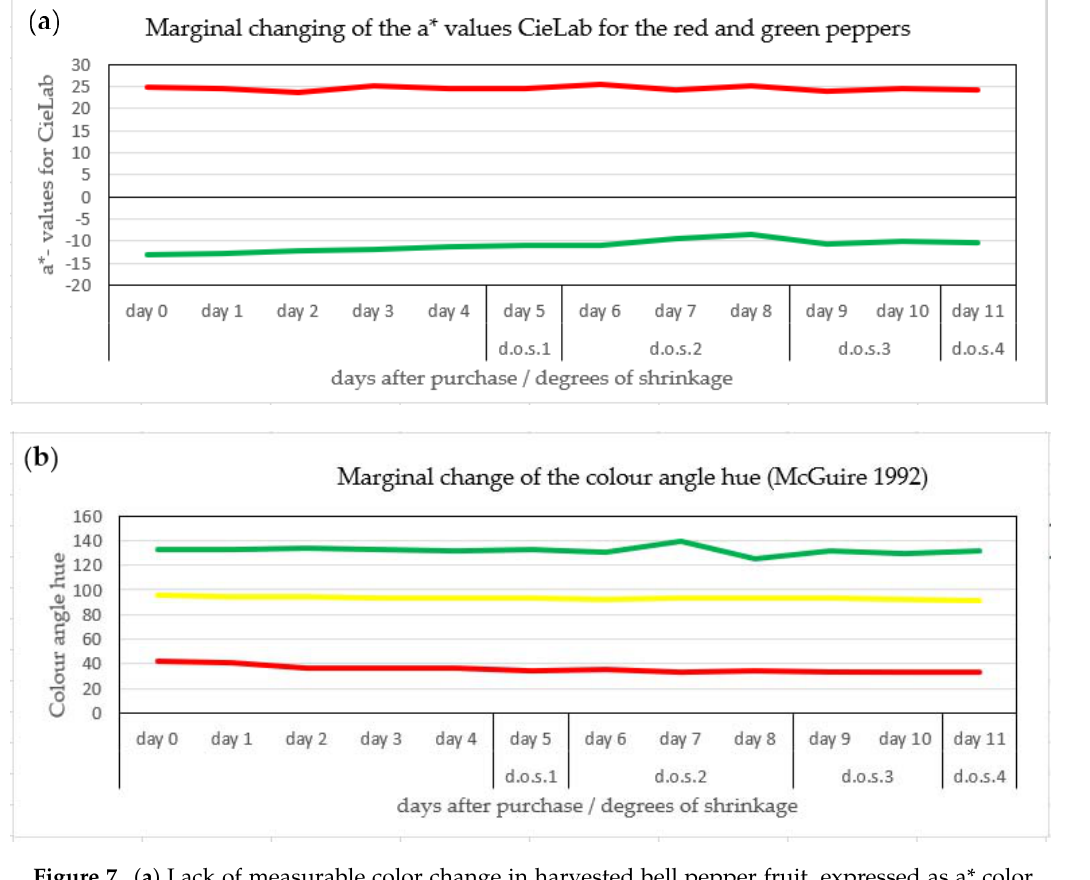
Figure 7. ( a ) Lack of measurable color change in harvested bell pepper fruit, expressed as a* color values (red or green) of red and green peppers and ( b ) hue color angle of red, green, and yellow peppers during 14 days of storage (n = 2 measurements per fruit per day).